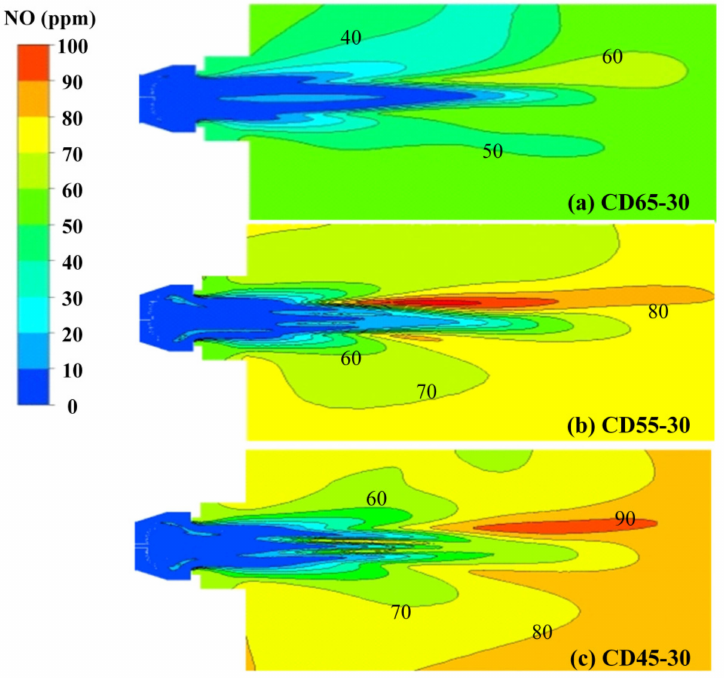
Figure 16. NO x local distribution of CD65-30, CD55-30, and CD45-30 on the central cross